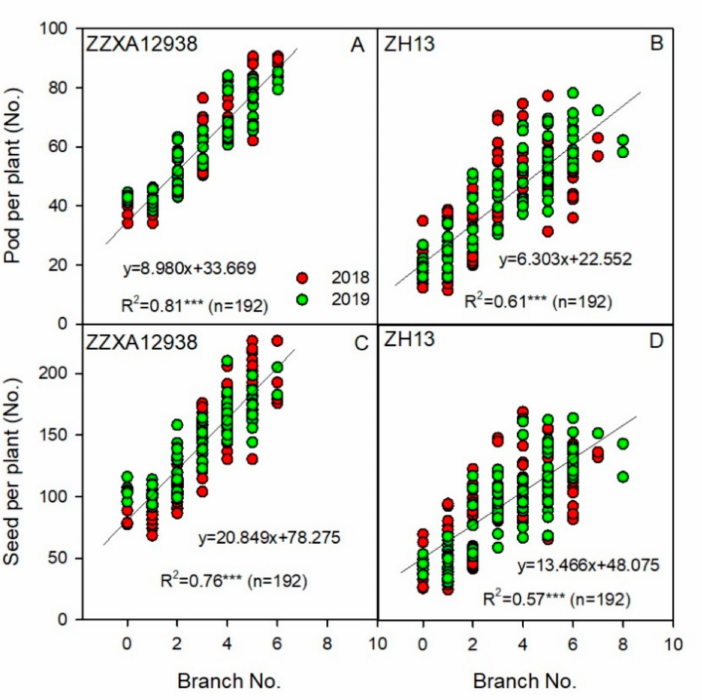
Figure 6. The relationship between pods and seeds per plant and branch number for ( A , C ) ZZXA12938 and ( B , D ) ZH13. Markers with different colors represent different growing season; *** indicates that the correlation is significant at the p ≤ 0.001